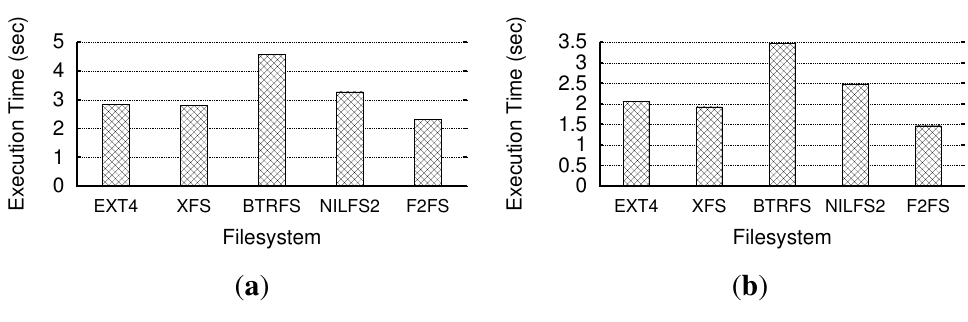
Table 3. Characteristics of captured trace using